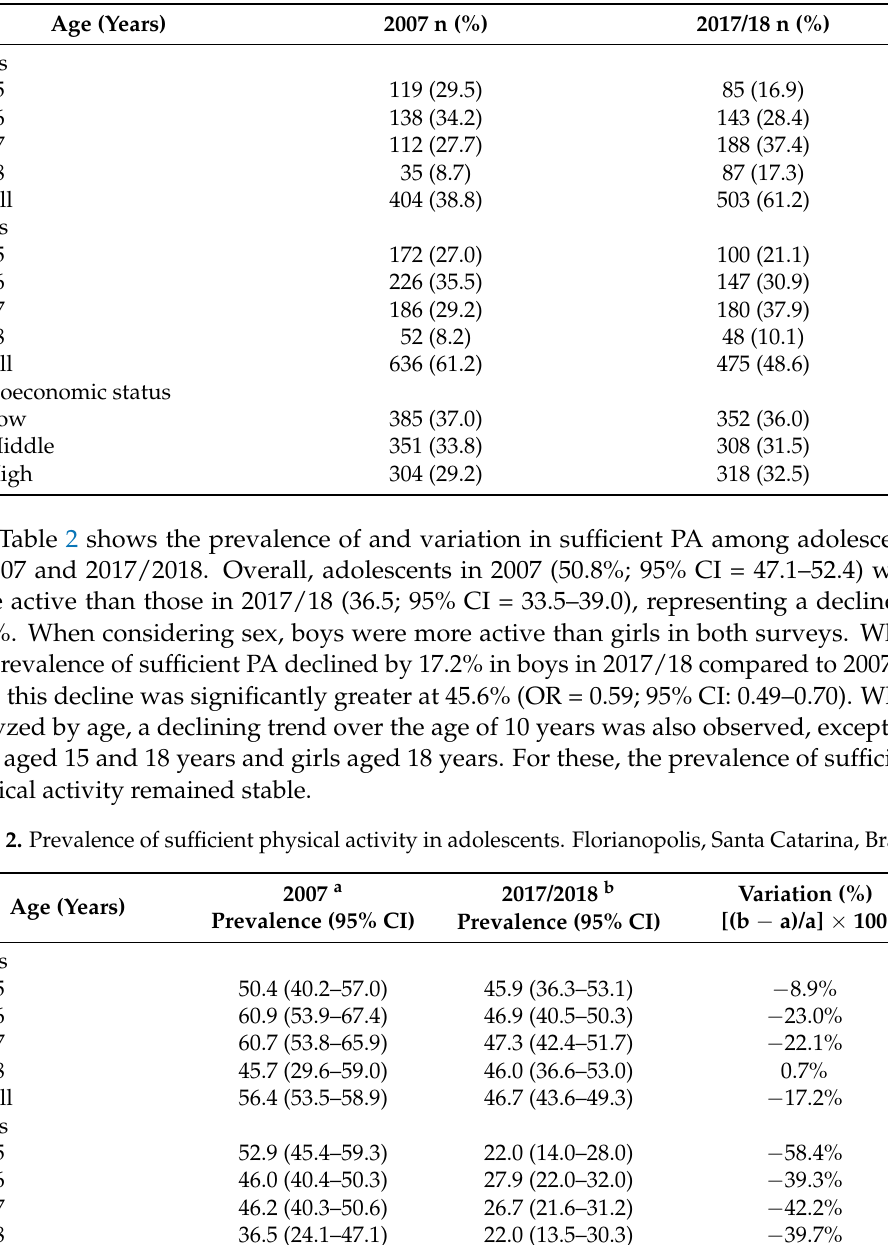
Table 1. Descriptive characteristics of the samples, Florianopolis, Santa Catarina, Brazil.